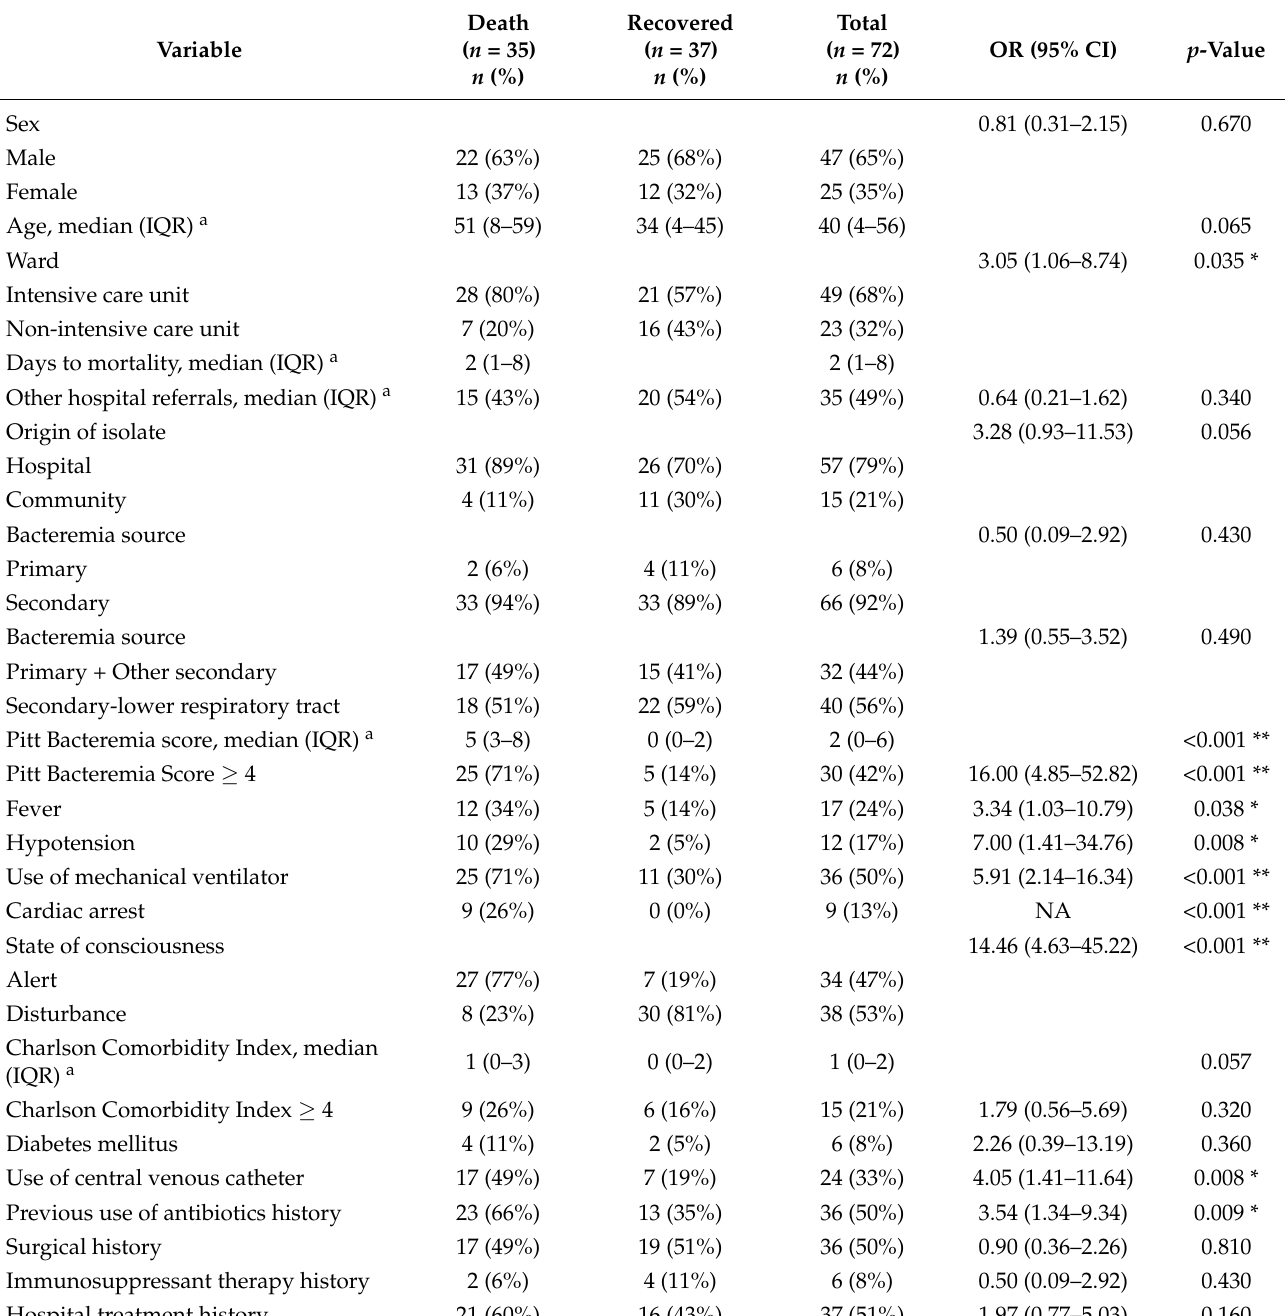
Table 4. Risk factors for mortality of bacteremia caused by CSAB ( n =